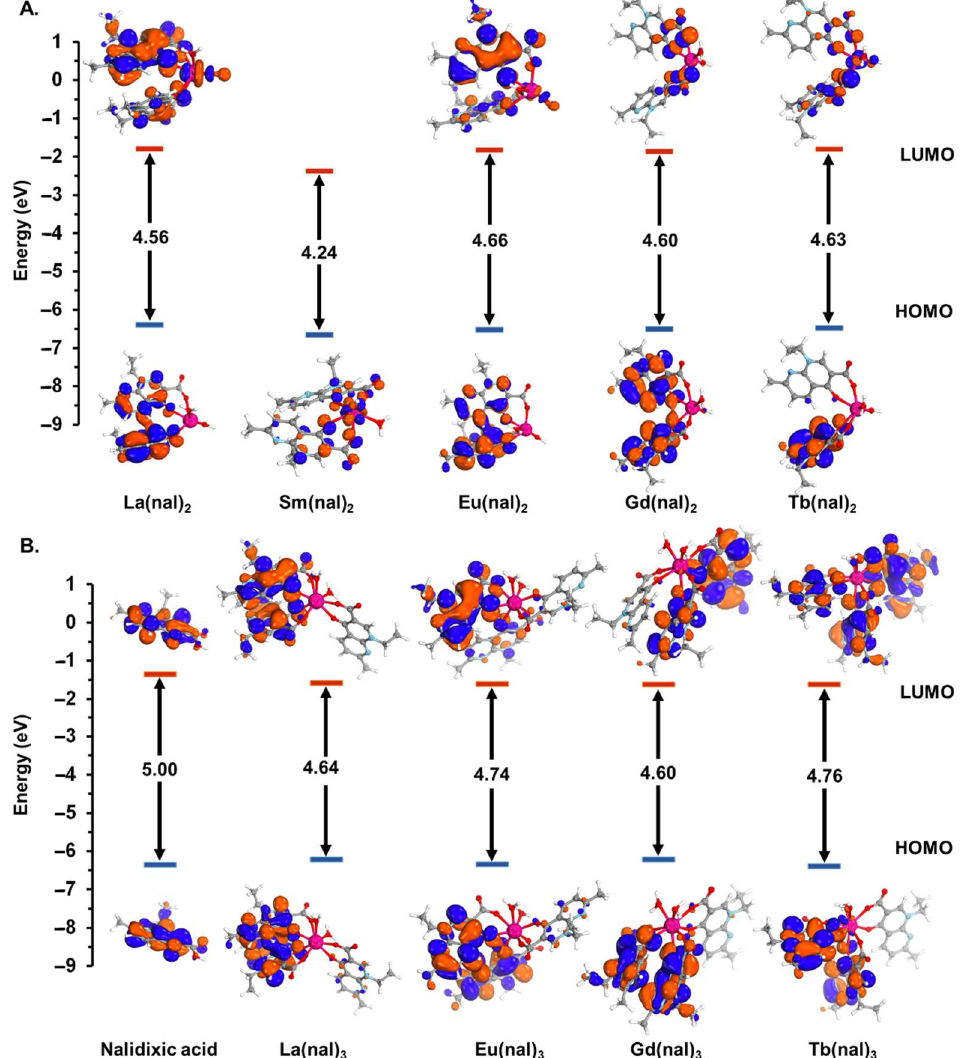
Figure 5. Plotted spatial distributions of the HOMO and LUMO and the HOMO–LUMO energy gaps computed for isolated molecules belonging to the M(nal) 2 ( A ) and the M(nal) 3 ( B ) series in DMSO using Orca program suite with PBE0 functional, with the RIJCOSX approximation and the CPCM solvation model. Red and blue isosurface colors denote + and − nodes, respectively.